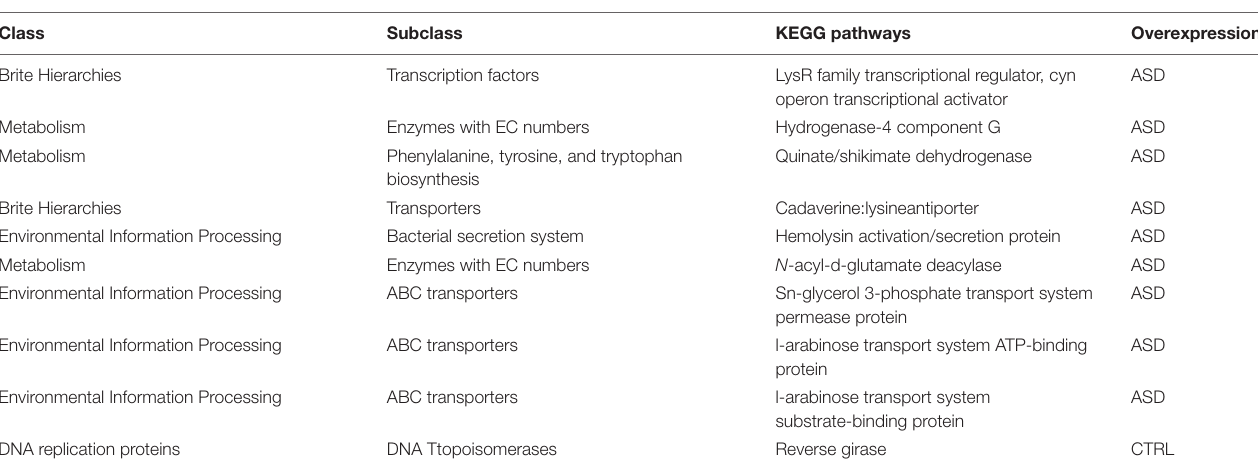
TABLE 2 | Overexpressed KEEG pathways in the patients with ASD and